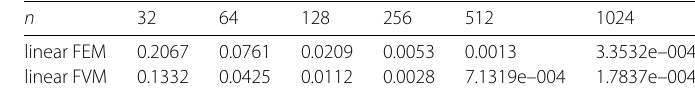
Table 9 The error in the relative discrete L 2 -norm for problem (5.2) with k =